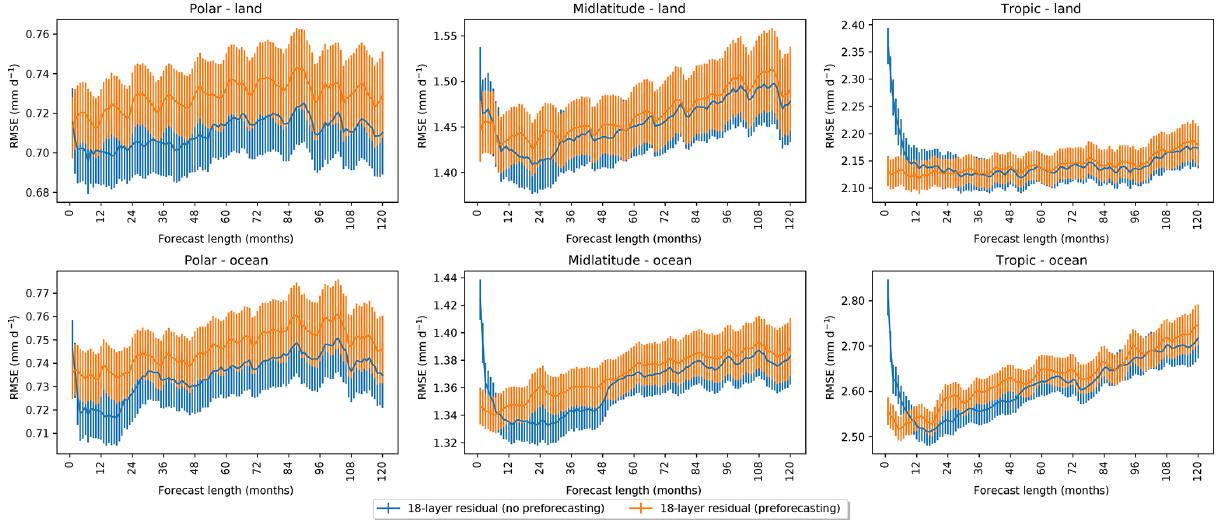
Figure 6. Comparing the RMSE for decadal precipitation forecasts with and without preforecasting. The model was trained using a win- dow size of 60, and 30 preforecasts were generated. Vertical bars denote the standard error over all possible starting dates in the test set. Preforecasting significantly reduces the RMSE for short-range forecasts without degrading long-range